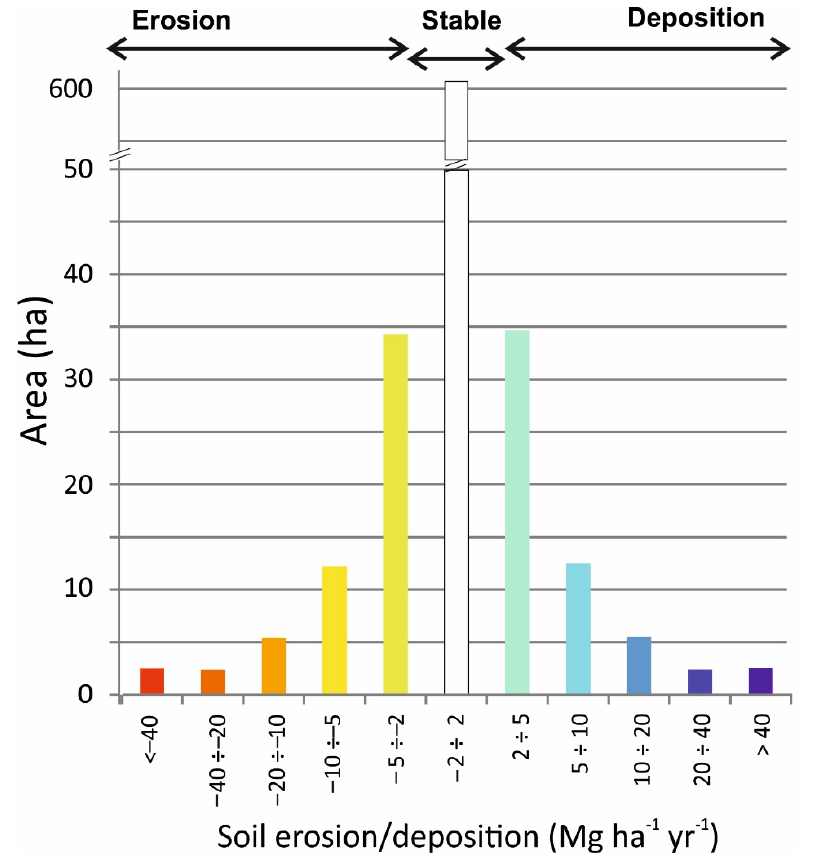
Figure 7. Histogram showing the distribution of areas for each class of the USPED model. Statistical analysis was performed within the studied catchment area. analysis was performed within the studied catchment area.